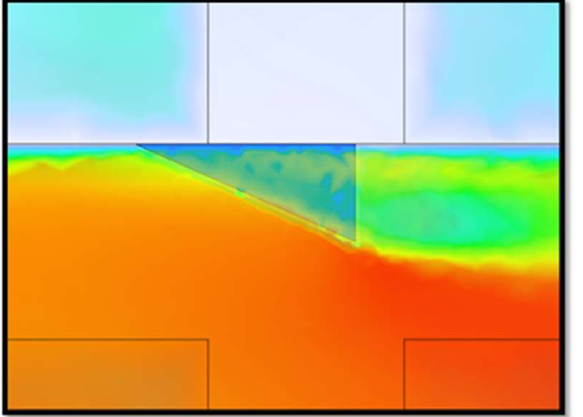
Figure 20. Air flow profile for the vortex generator design.